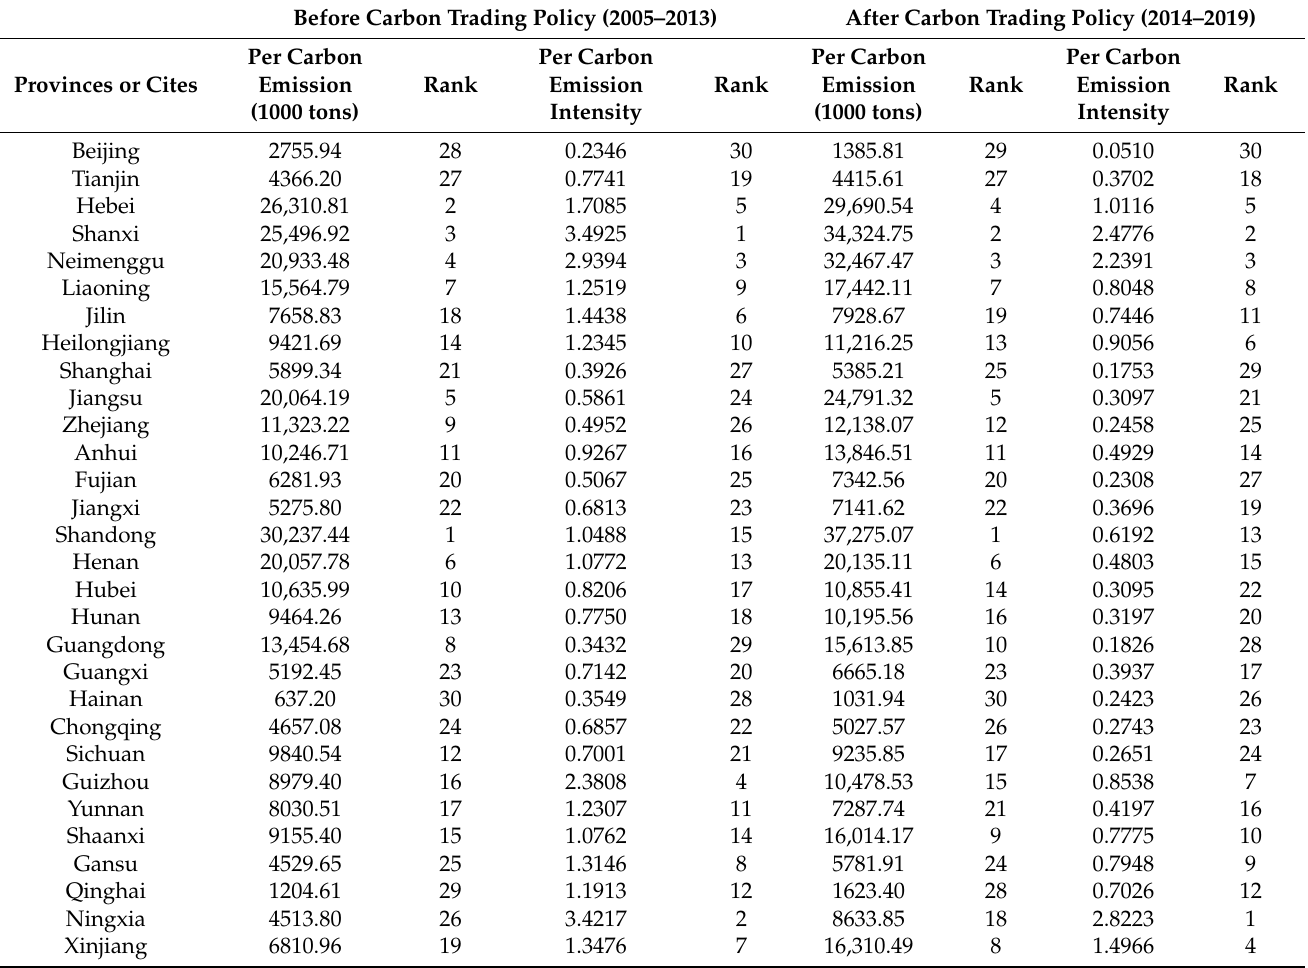
Table 5. The carbon emission, intensity, and rank of provinces or cities before and after the carbon trading policy.